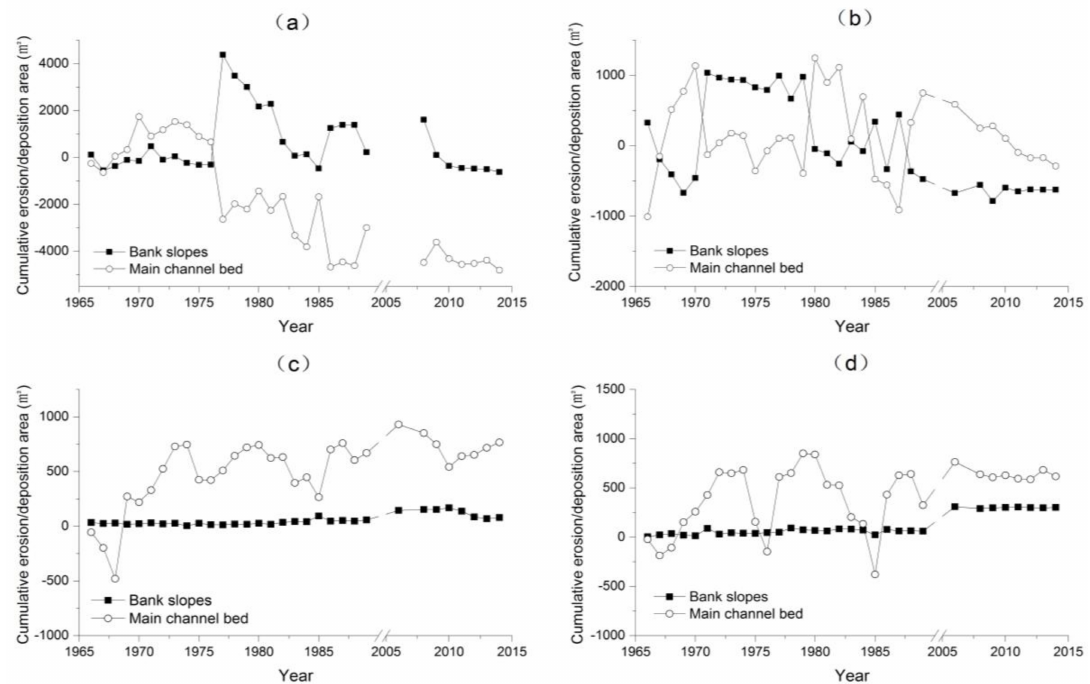
Figure 8. Cumulative erosion/deposition of bank slopes and main channel bed in Jiahetan ( a ), Gaocun ( b ), Luokou ( c ), and Lijin ( d ) sections of the lower Yellow